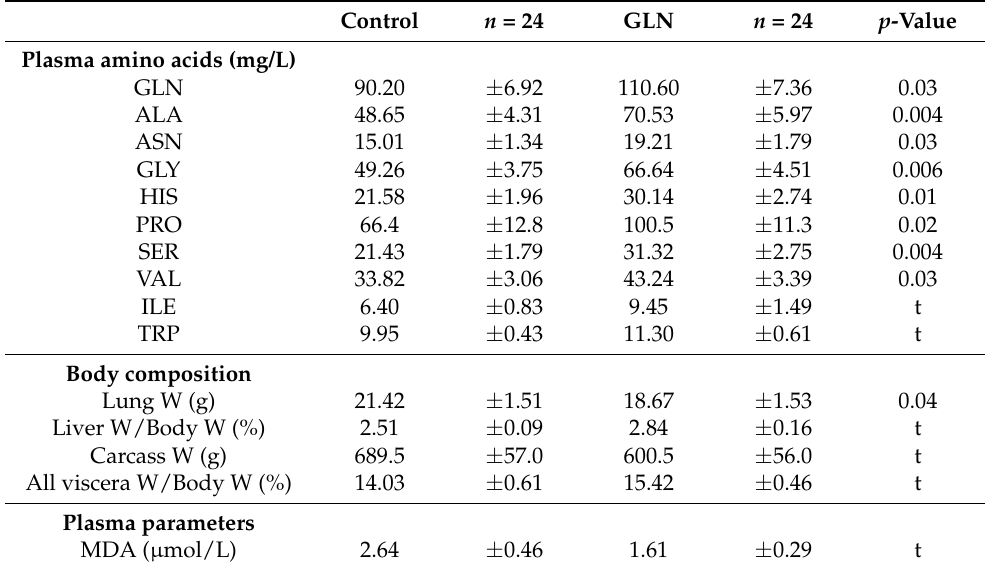
Table 1. Significant differences between control and treated (GLN) newborns at birth. Mean ± SE.